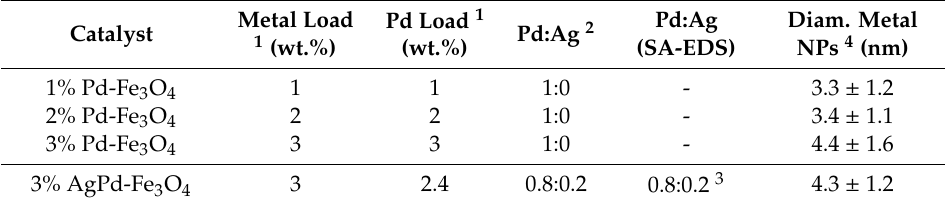
Table 2. Characteristics of the metal nanoparticles (NPs) on the magnetite-based catalysts. Metal Load Catalyst 1